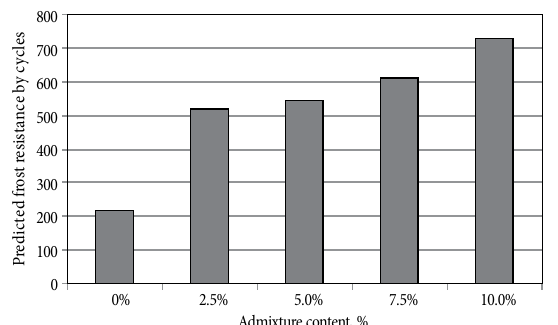
Fig. 7. Function of predicted frost resistance by cycles and amorphous alumina silicate admixture